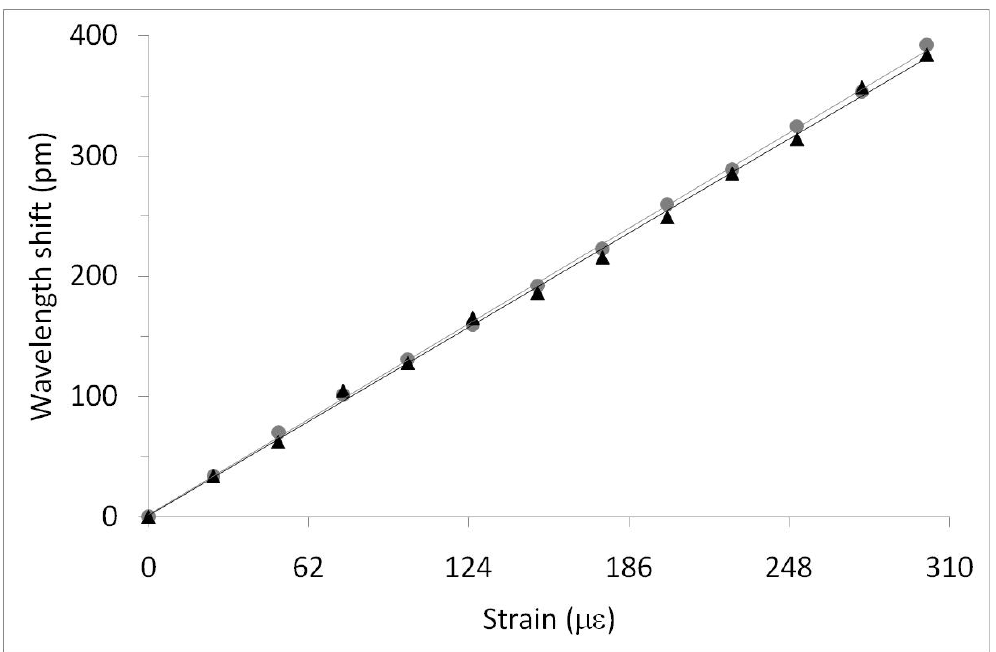
Figure 4. Longitudinal strain response for PM FBG in both the Fast and Slow axes of the fiber (1.264 ± 0.02 pm/  and 1.282 ± 0.009 pm/  for slow and fast axes respectively). ● (grey), Fast and ▲ (black), Slow